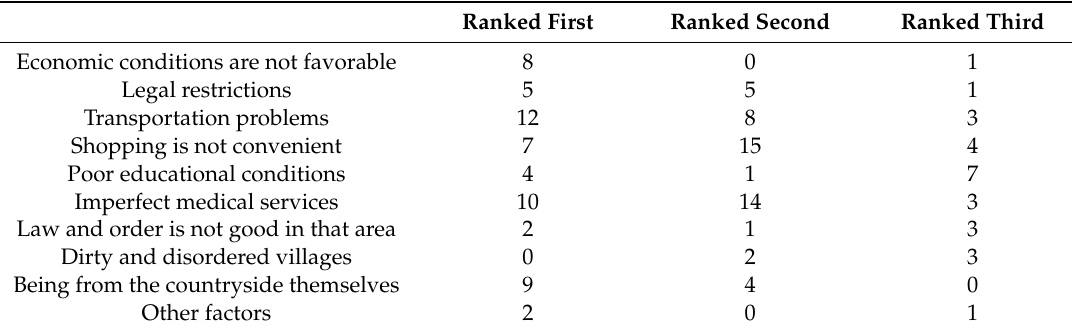
Table 7. Reasons for unwillingness to sell a rural